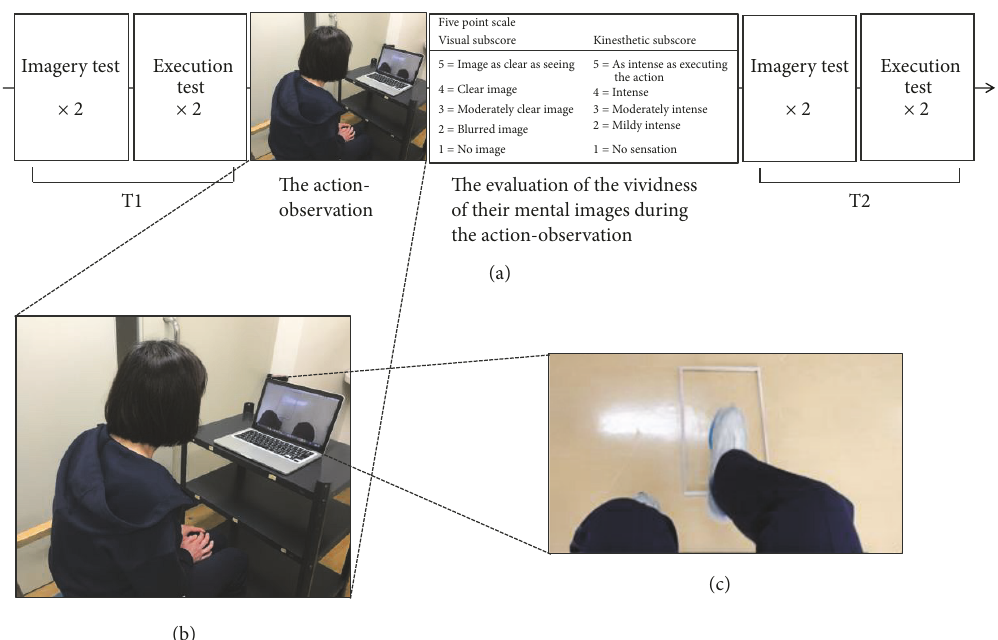
Figure 1: (a) The experimental procedures. Imagery and execution times were assessed before (T1) and after (T2) the action-observation. (b) During the action-observation,the participants were seated in a relaxed position. The video clips were presented at 0.5 × speed on a computer screen. (c) The stepping movements presented in the video clips were shown in a first-person perspective. For the self-observation (SO) condition, participants were presented video clips of their own stepping movements. For the other-observation (OO) condition, participants were presented with clips of others performing the stepping movements. The order of the two conditions was